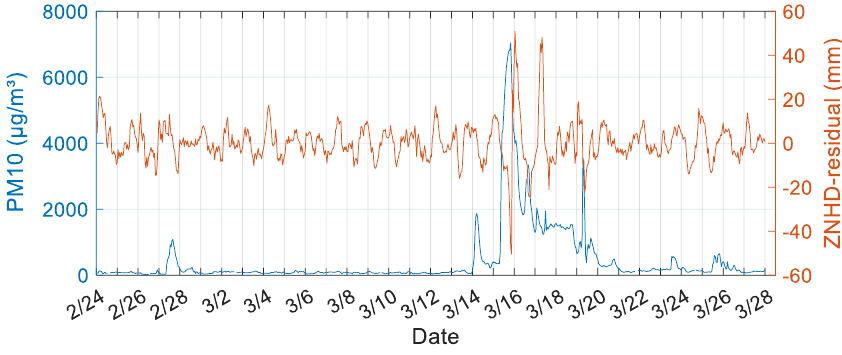
Figure 11. Variations in the PM10 and ZNHD residual at NXZW station.